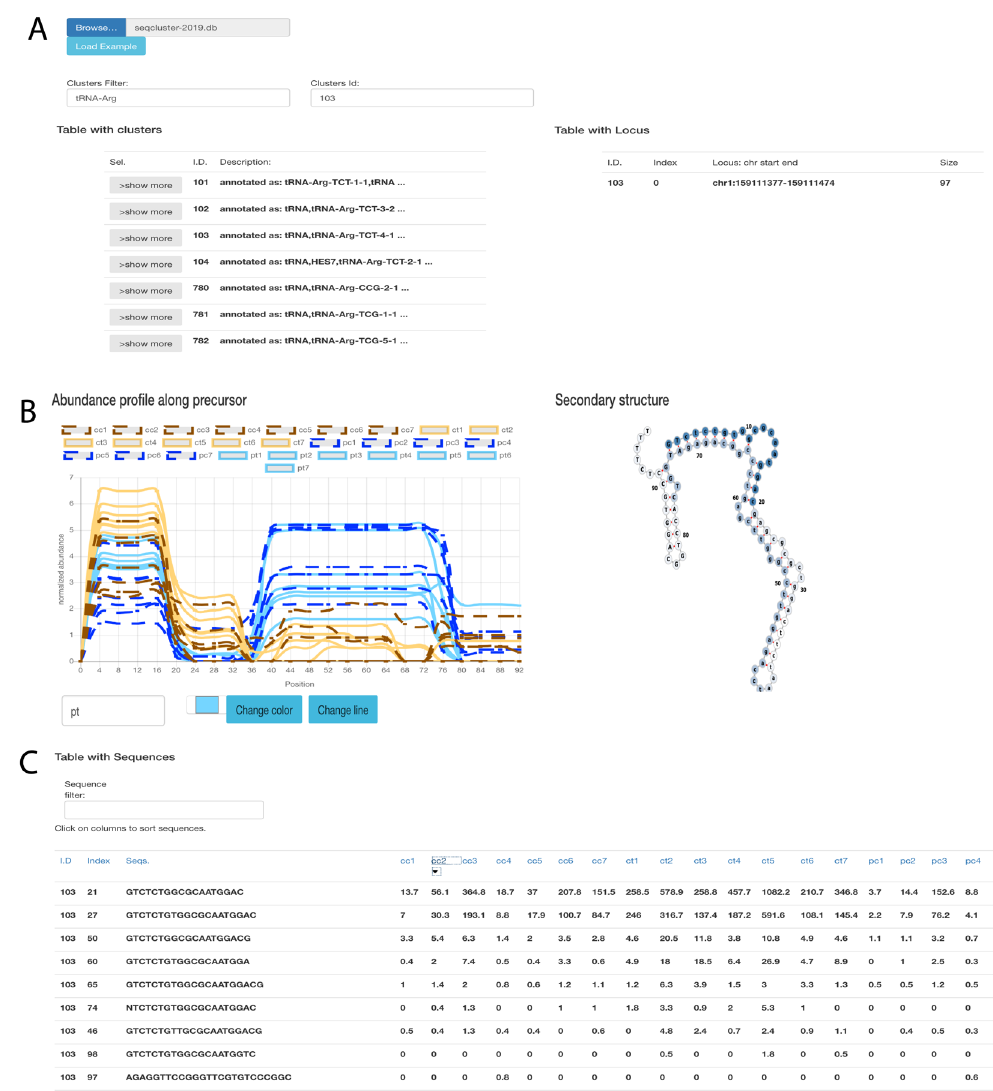
Figure 1. seqclusterViz features. ( A ) Top panel with table showing the list of small RNAs detected (left) and genomic location (right). ( B ) Middle panel shows abundance profile over the precursor (left), and secondary structure (right). This is an example of batch effect at the 3’ end (blue higher than brown) and disease effect at the 5’ end (solid lines higher than dashed lines). ( C ) Bottom panel shows a table with the top most expressed sequences on the selected small RNA transcript. The index column is the sequence identifier that links the results to the original seqcluster output